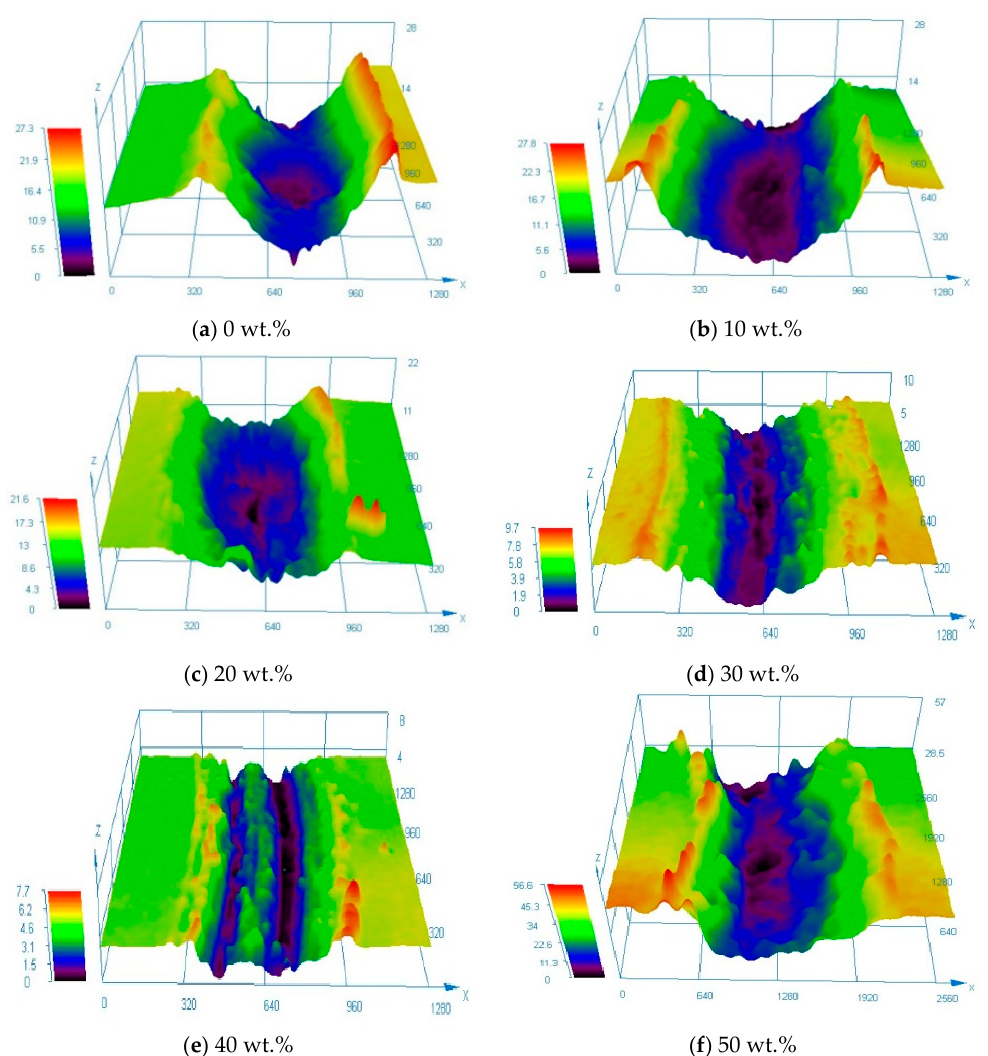
Figure 6. Surface morphologies of laser cladded Ni45 + high-carbon ferrochrome coatings after wear